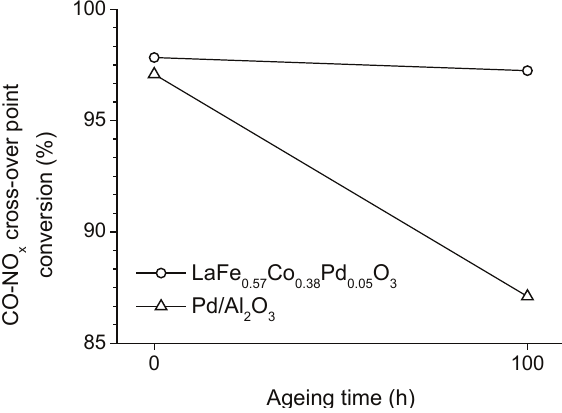
B ' O ( B ' = Pd, Pt, Rh) actually forming a 0.95 0.05 3